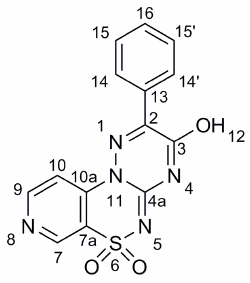
Figure 3. The structure of 2-phenyl-3-hydroxypyrido[4,3- e ][1,2,4]triazino[3,2- c ][1,2,4]thiadiazine 6,6-dioxide 7 ; the atom numbers are correlated with the NMR results.